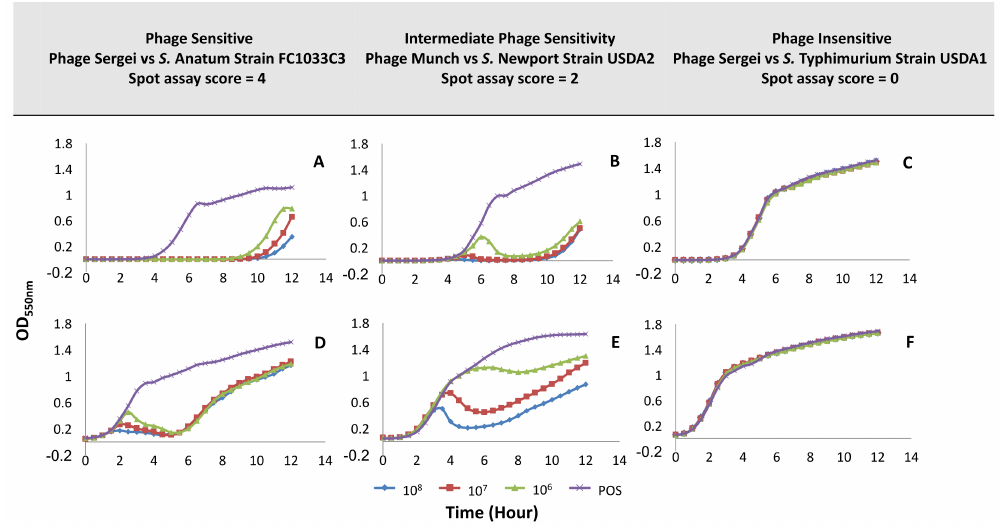
Figure 3. Sample growth curves illustrating different phage sensitivity phenotypes in the low- and high-inoculum experimental setups. The X-axis indicates the OD 550nm and the Y-axis represents the time in hours. Panels ( A – C ): experiments run with the low bacterial inoculum condition (~10 5 CFU/mL); panels ( D – F ): experiments run with the high bacterial inoculum condition (~10 8 CFU/mL). Both conditions were challenged with phage at 10 8 PFU/mL, 10 7 PFU/mL, and 10 6 PFU/mL; POS: positive culture control with no phage. Phage-host pairs were selected based on their scores from the spot host range assay, which was shown in Figure